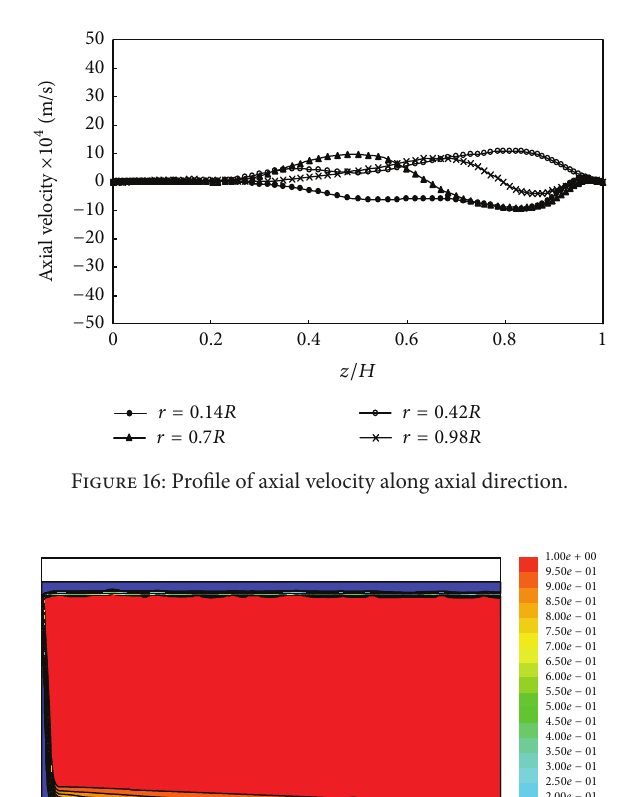
Figure 15: Contours of stream function field.